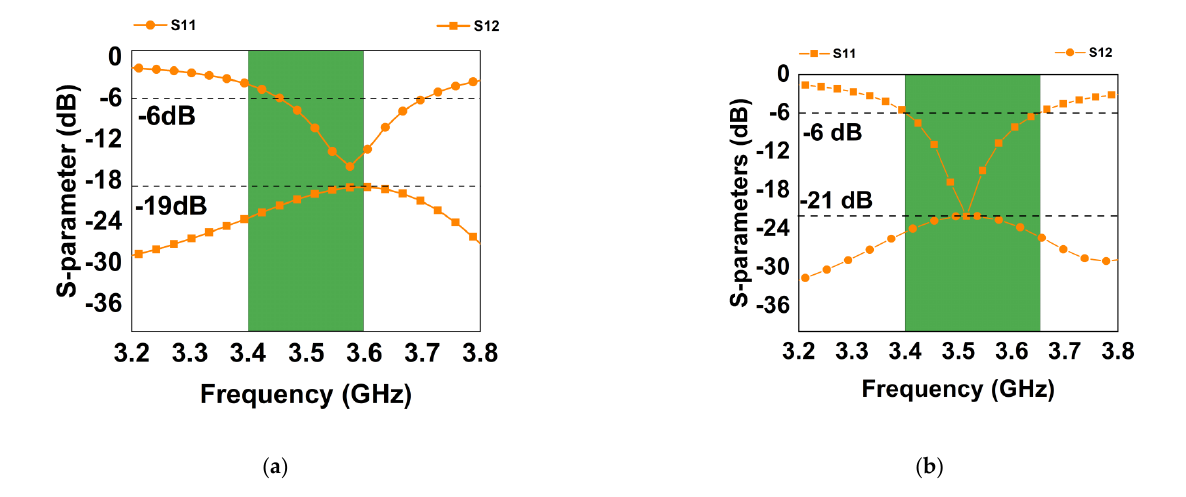
Figure 4. Simulated S-parameter ( a ) with no decoupling element ( b ) with the decoupling element.